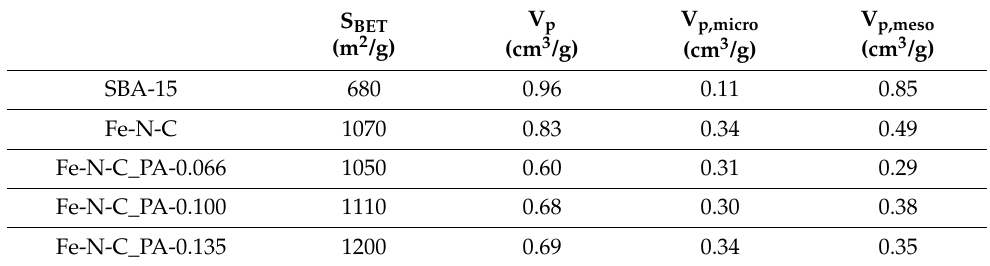
Table 1. Specific surface areas and pore volumes of SBA-15 and Fe-N-C catalysts. (S BET : BET specific surface area. V p : pore volume, V p micro : micropore volume, V p,meso : mesopore